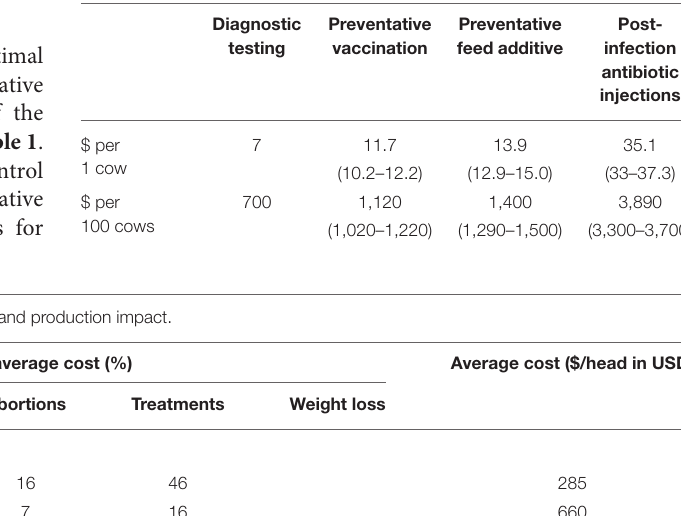
TABLE 3 | Estimated costs for anaplasmosis control strategies by herd size (in USD).